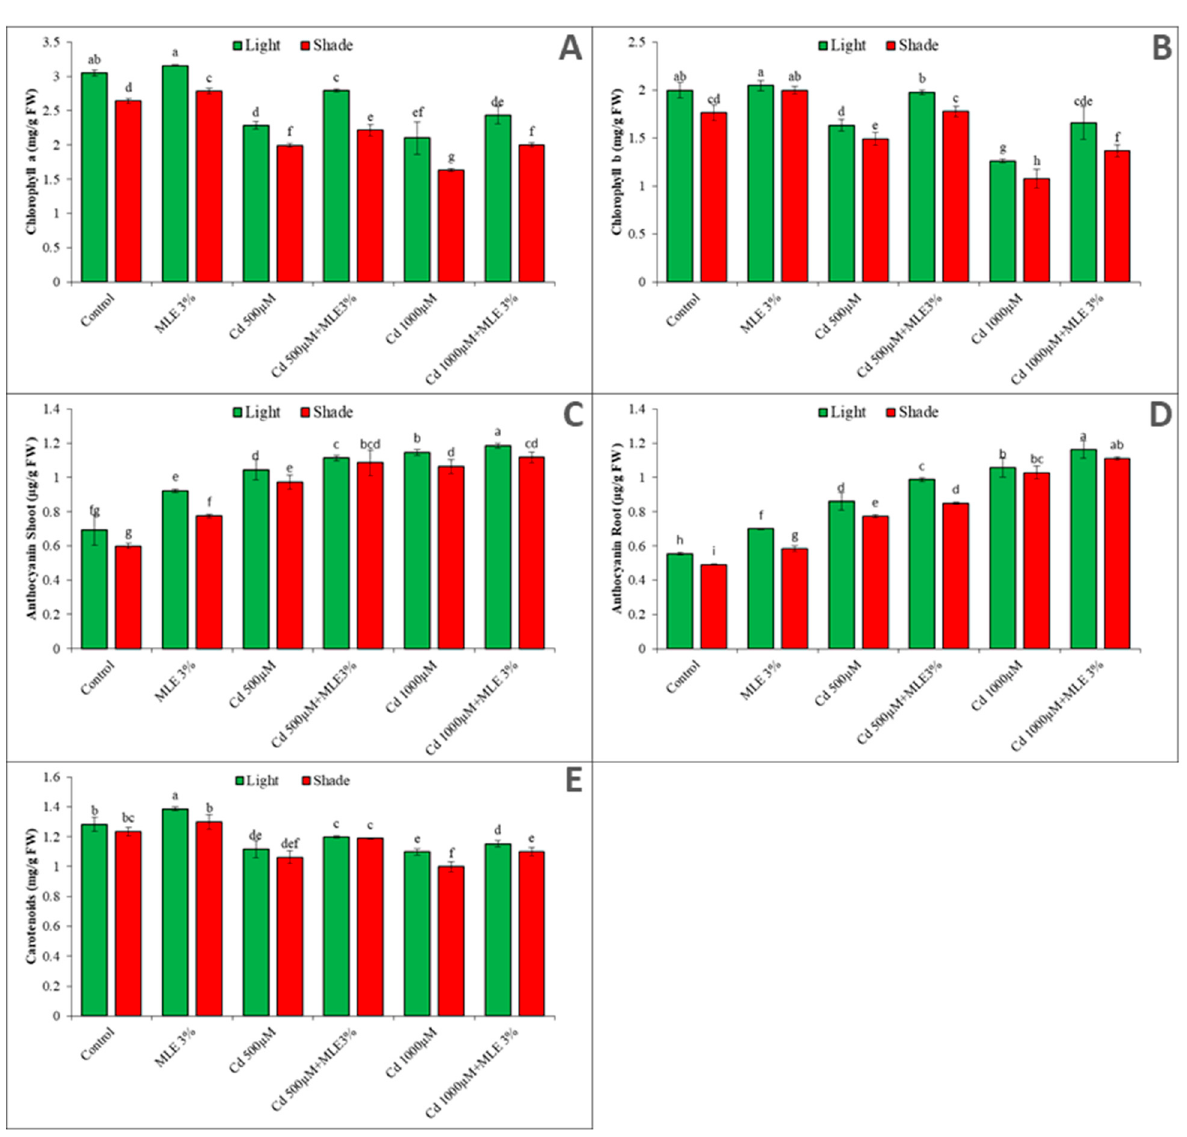
Figure 3. Effect of MLE application on plant pigments ( A ) chlorophyll a content ( B ) chlorophyll b content ( C ) anthocyanin of shoot ( D ) anthocyanin of root and ( E ) carotenoids content, with and without Cd stress under light and subdue light. Different letters above bars represents significant differences ( p < 0.05) at each measured point. Values represent mean ± SE of three replicates of each treatment.